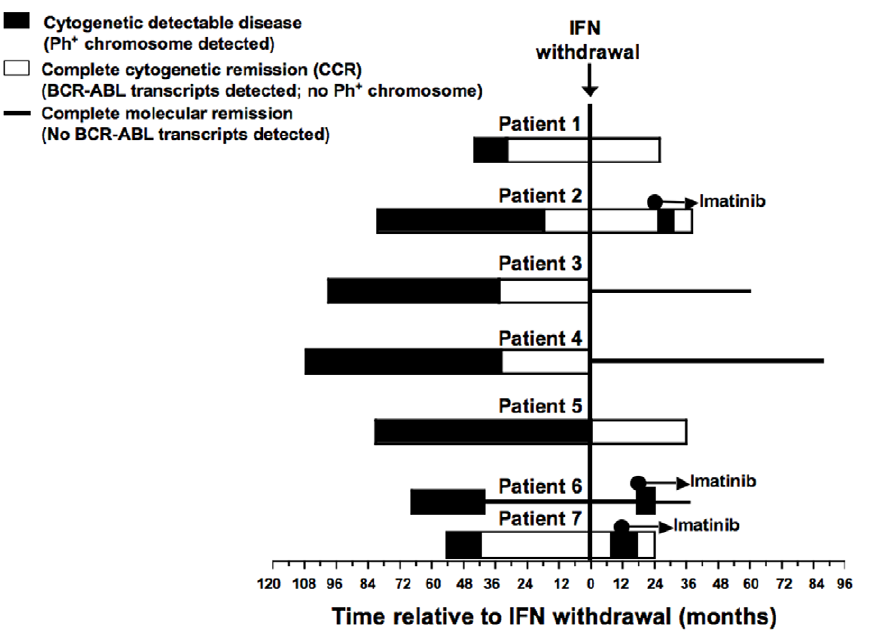
Figure 1. Longitudinal disease burden of CML patients in complete cytogenetic remission (CCR) after withdrawal of IFN treatment. Disease characteristics of seven HLA-A2 + patients in whom IFN treatment was withdrawn. Patients received IFN starting from the time of diagnosis (left-most time point) until it was stopped (denoted as time=0). For each patient, closed bars denote time points when any Ph + chromosome was detected in bone marrow, open bars denote time points when no Ph + chromosomes were detectable (complete cytogenetic remission, CCR) but BCR-ABL transcripts were detectable by QR-PCR, and the solid line denotes time points when BCR-ABL transcripts were not detectable (complete molecular remission). Arrows denote when certain patients received imatinib monotherapy.